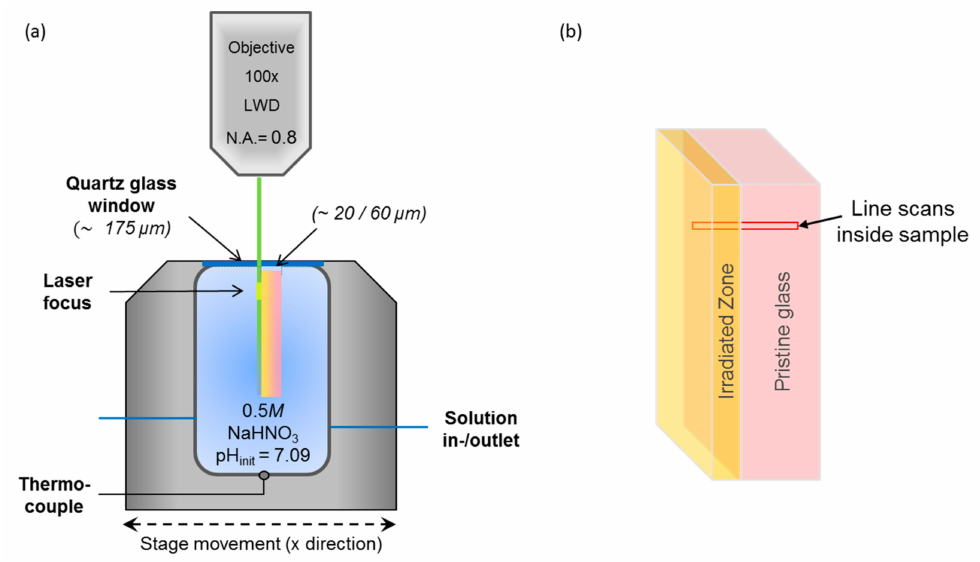
Figure 3. ( a ) Schematic drawing of the fluid cell (not to scale) used in this study, and ( b ) the location of the Raman spectroscopic line scans cross the heavy ion bombarded (5 × 10 12 Au ions / cm 2 ) surface layer into the non-irradiated